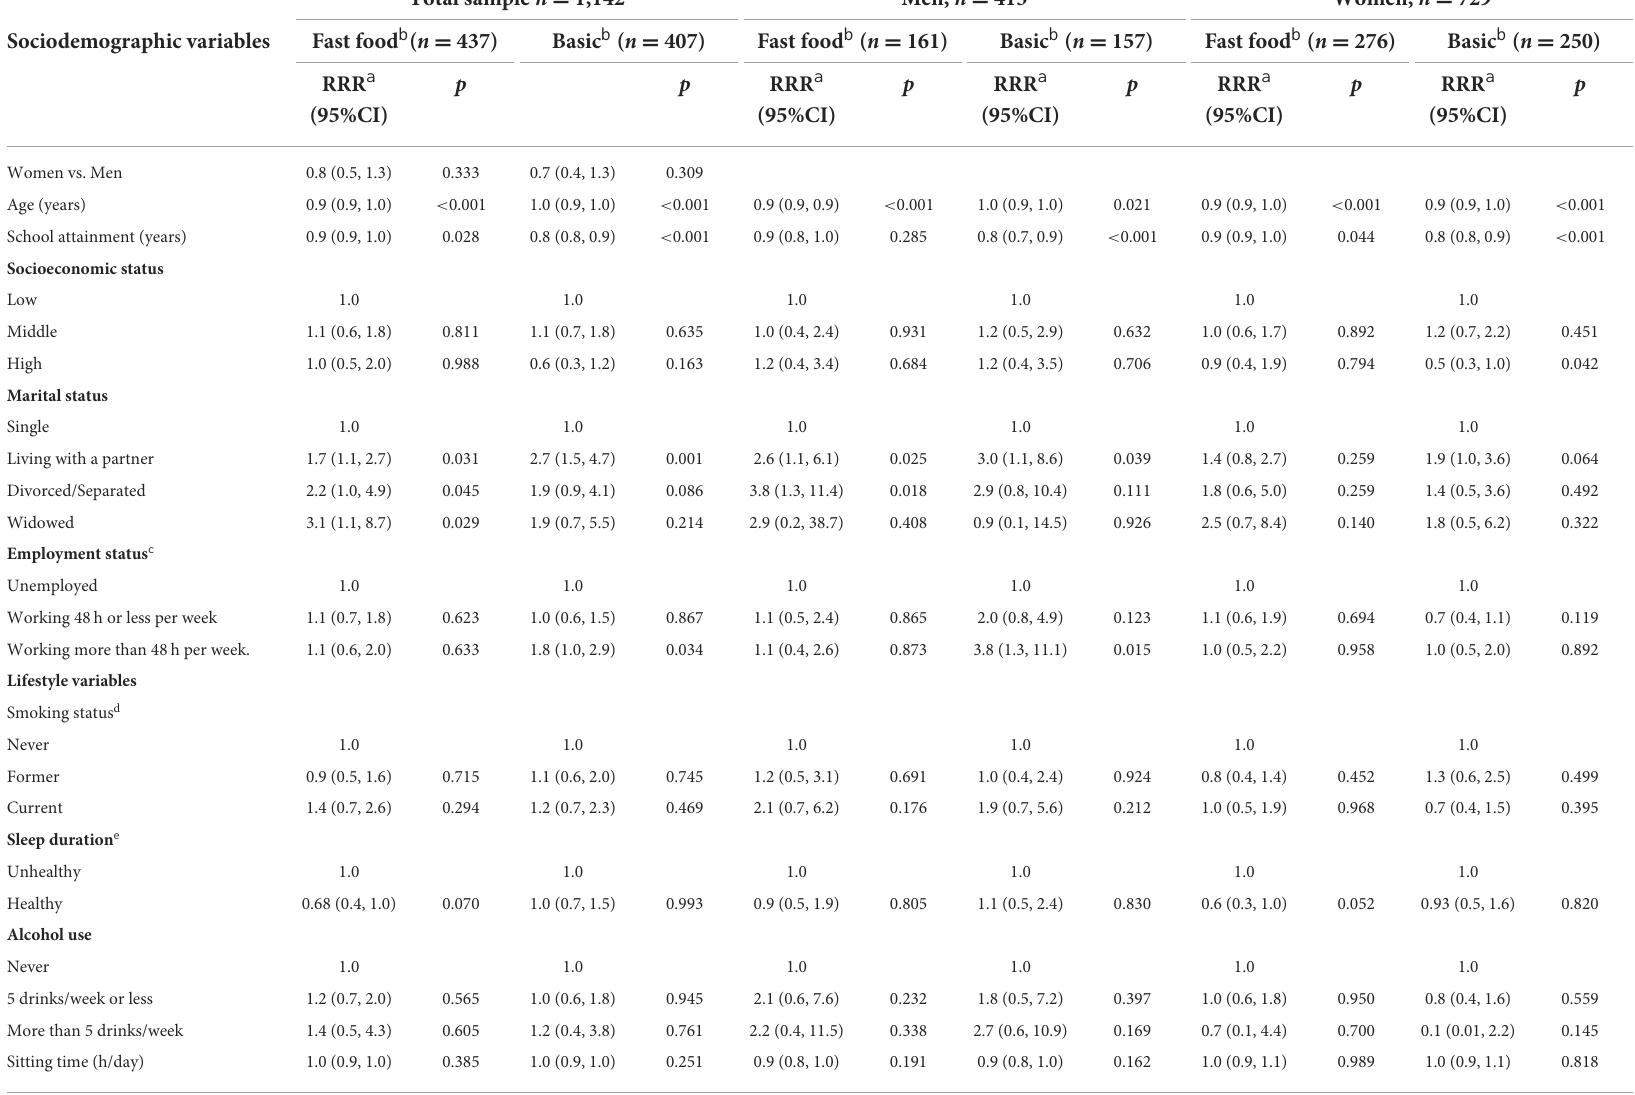
TABLE 3 Adjusted and sex-stratified association between sociodemographic and lifestyle factors with dietary patterns (Mexico City, 2015). Total sample n = 1,142